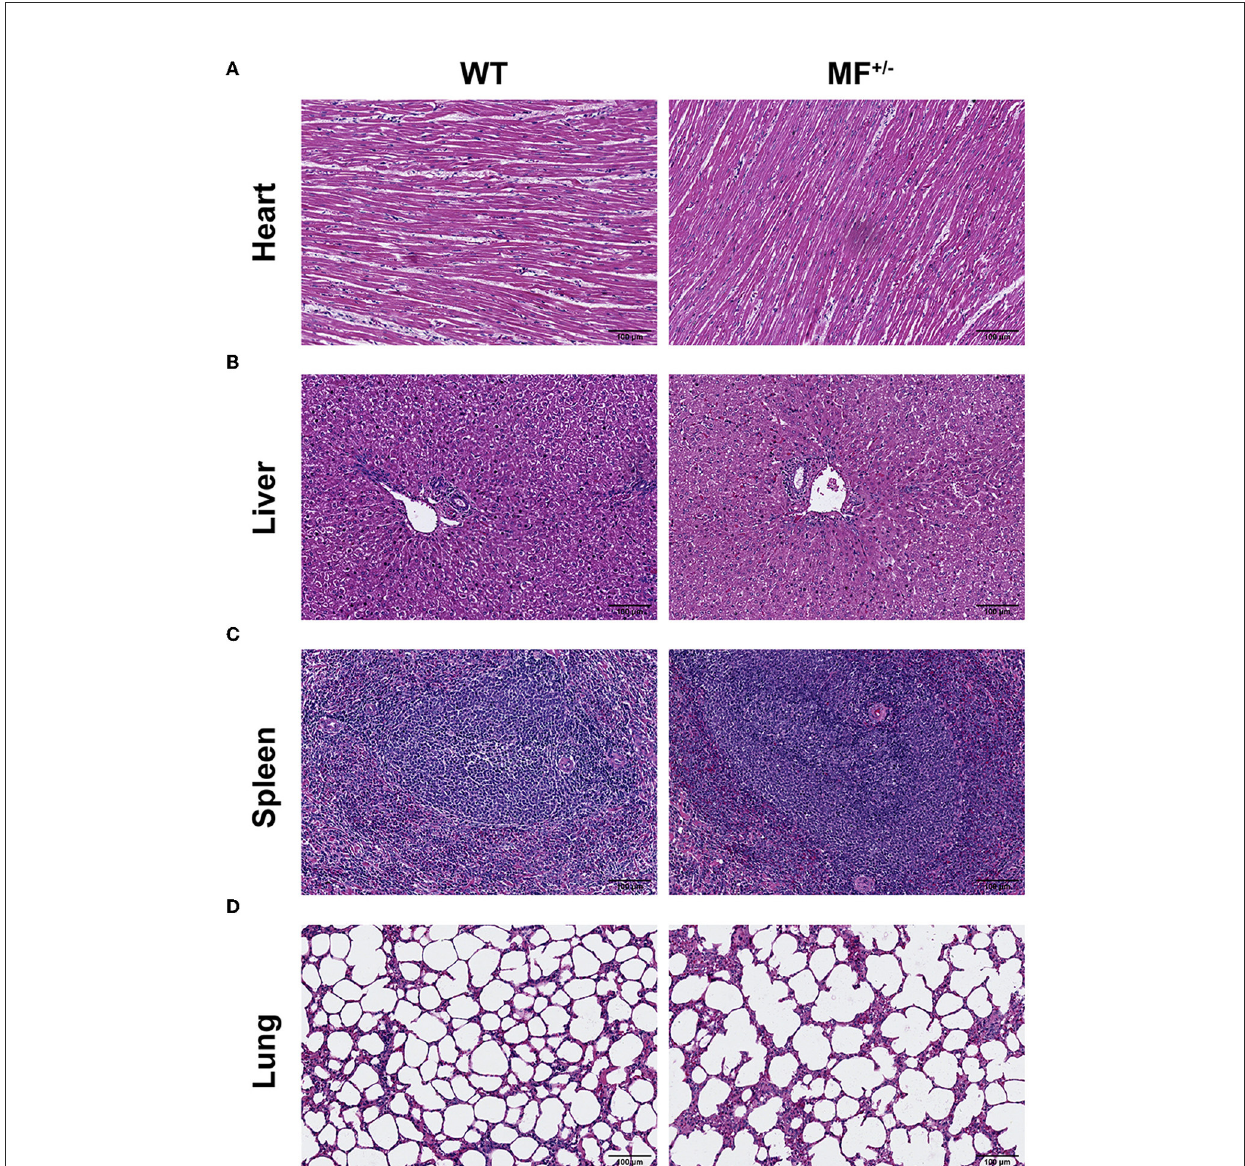
FIGURE3 Histological analysis of heart, liver, spleen and lung in WT and MF +/- sheep. (A–C) Representative pictures of HE staining of heart (A) , liver (B) , spleen (C) , and lung (D) in 12-month-old WT and MF +/- sheep. Scale bar 100 µ m.